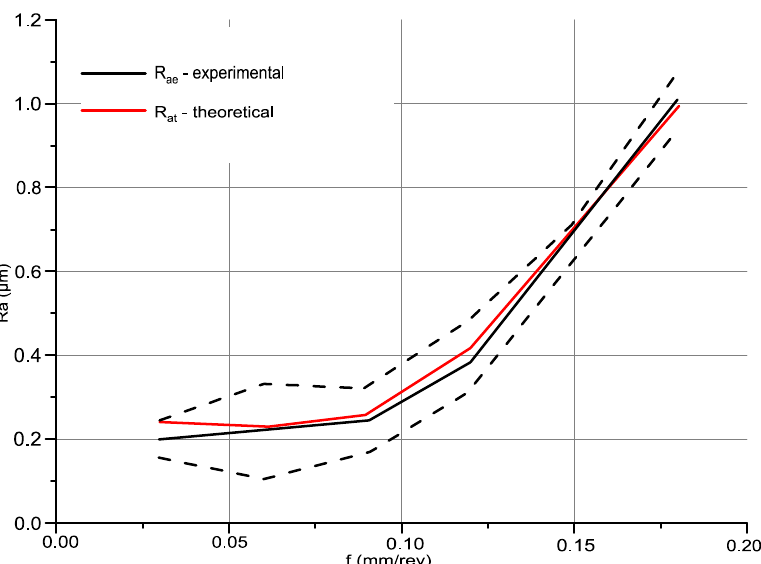
Figure 10. A graph showing the measured and projected Ra parameter of the longitudinally turned surface.